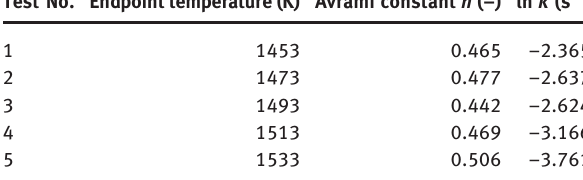
Table 3: Obtained results of Avrami constant n and crystallization rate constant ln k of phosphate-enriched phase in steelmaking slags at five endpoint temperatures.